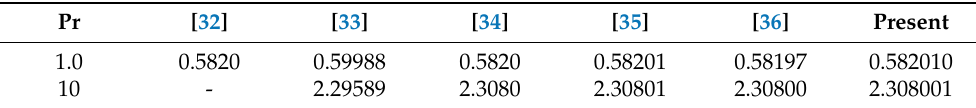
Table 2. Comparison of non-dimensional temperature gradients in the absence of δ , l , β v , λ ∗ , β t , Ec